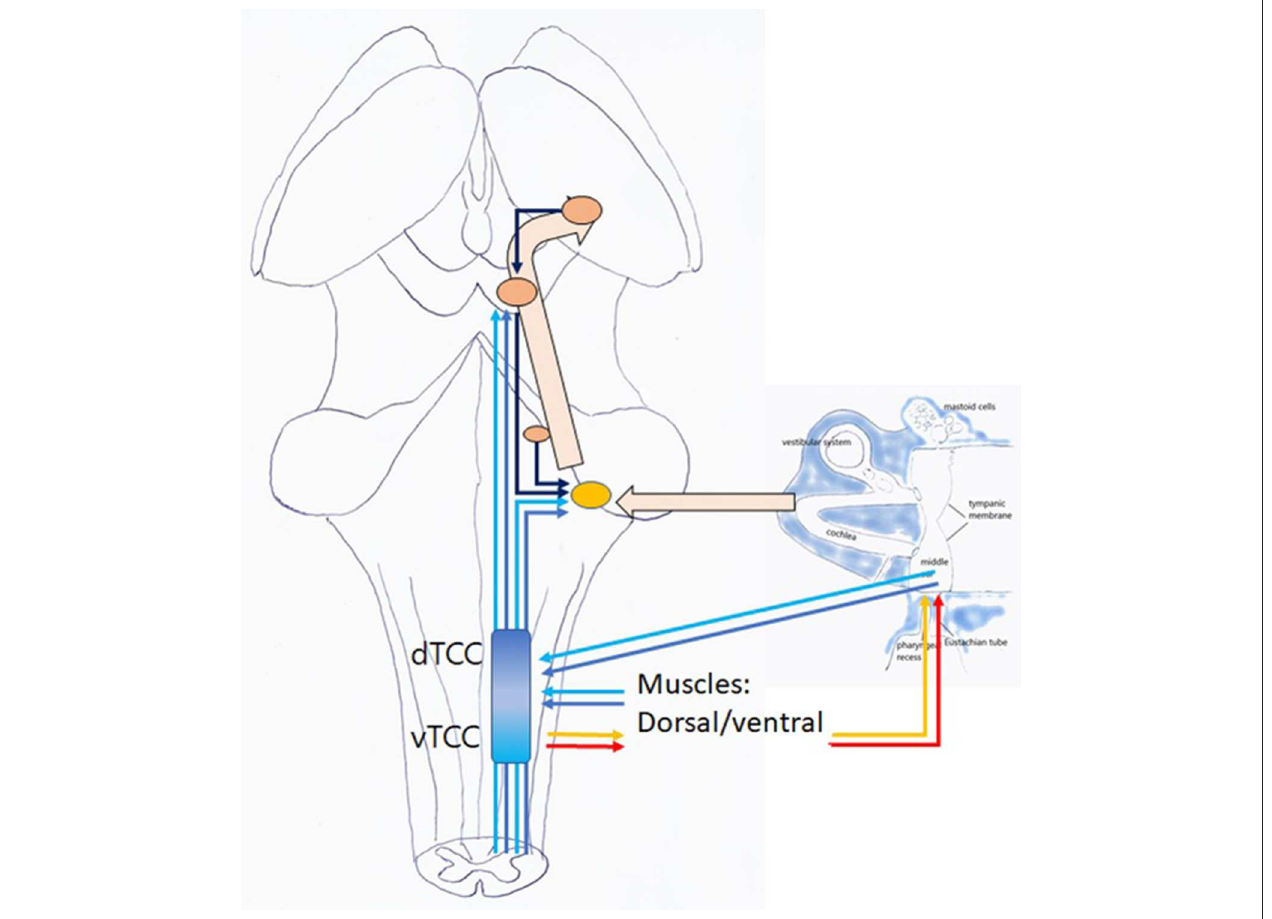
FIGURE 11 | Listening: this is an active, voluntary process (unconscious or conscious). TCC with afferent dTCC (dark blue) and vTCC (light blue); efferent TMRF upward (red); and downward shifting (yellow).